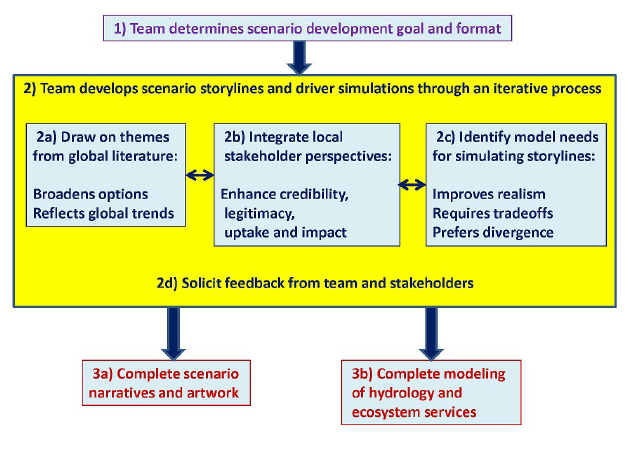
Fig. 4. Steps in the scenario development process. Modified from Kok (2009) and Alcamo